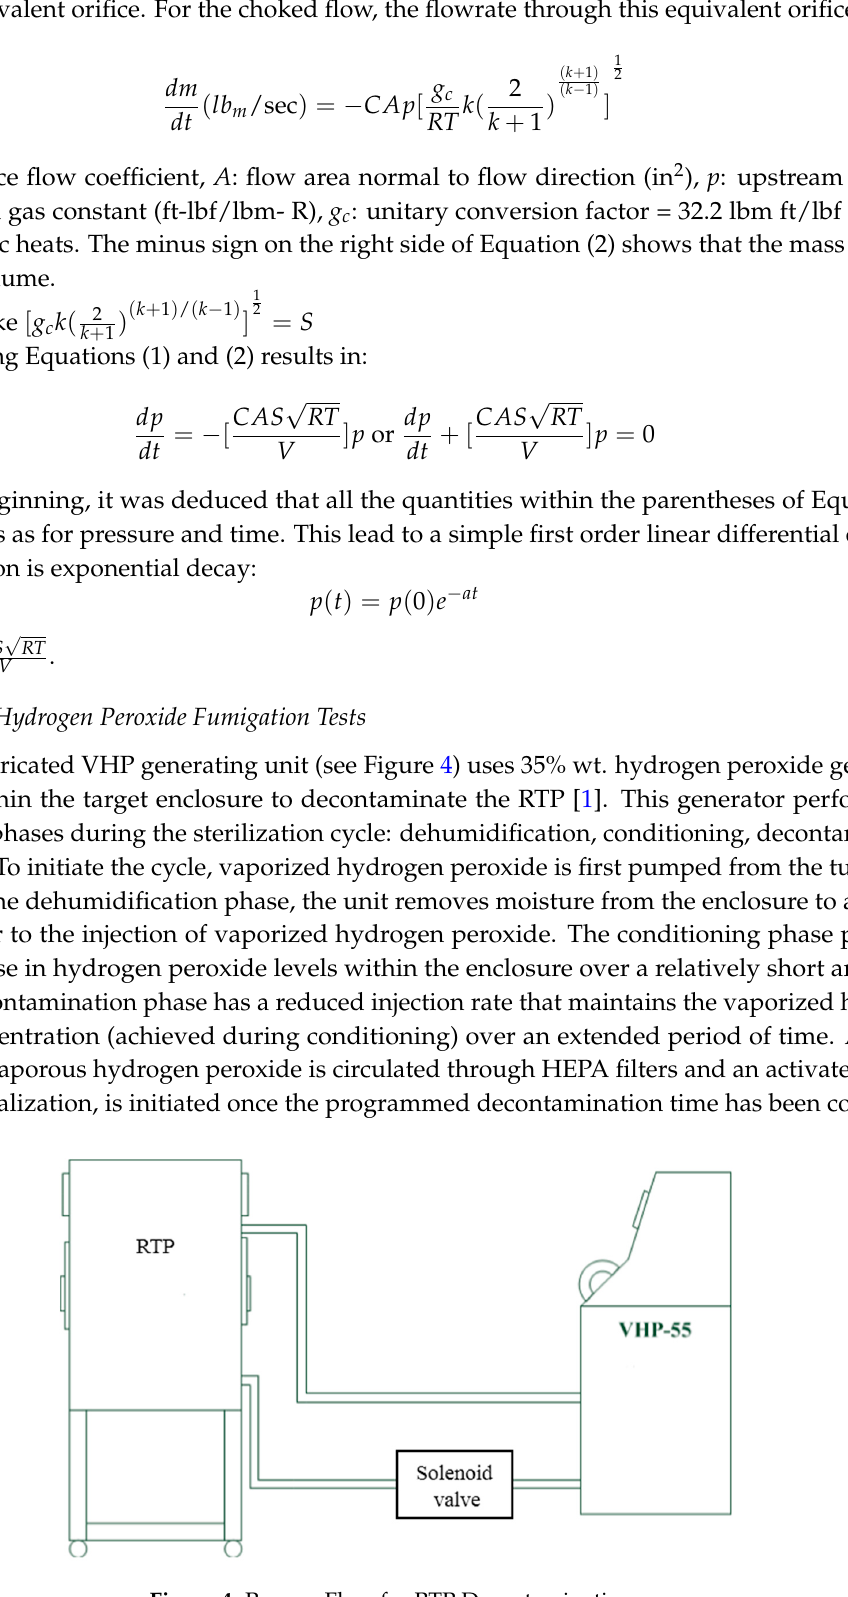
Figure 4. Process Flow for RTP